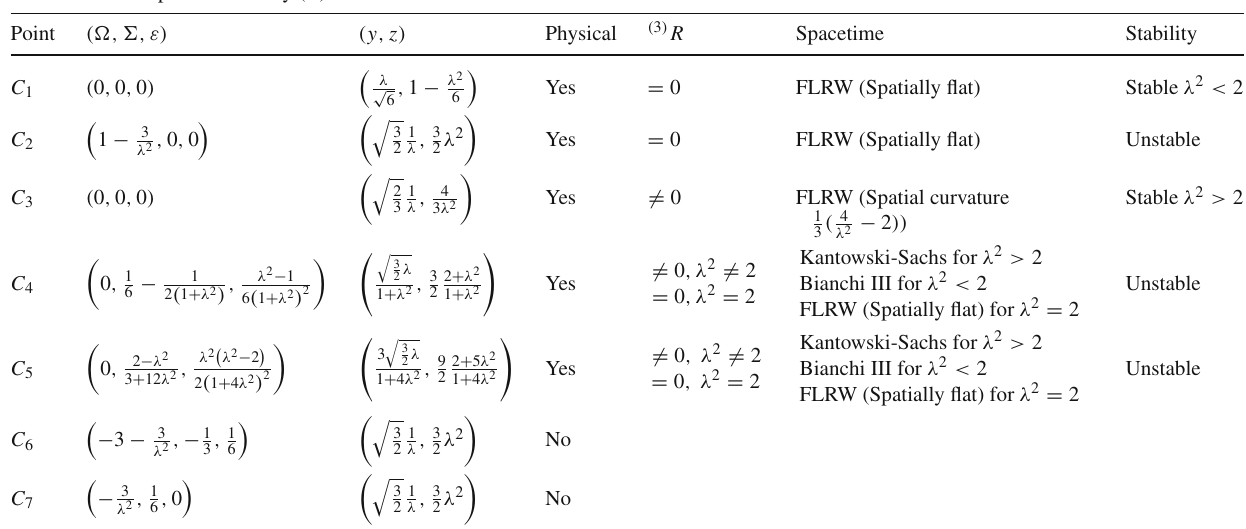
Table 3 Critical points of family